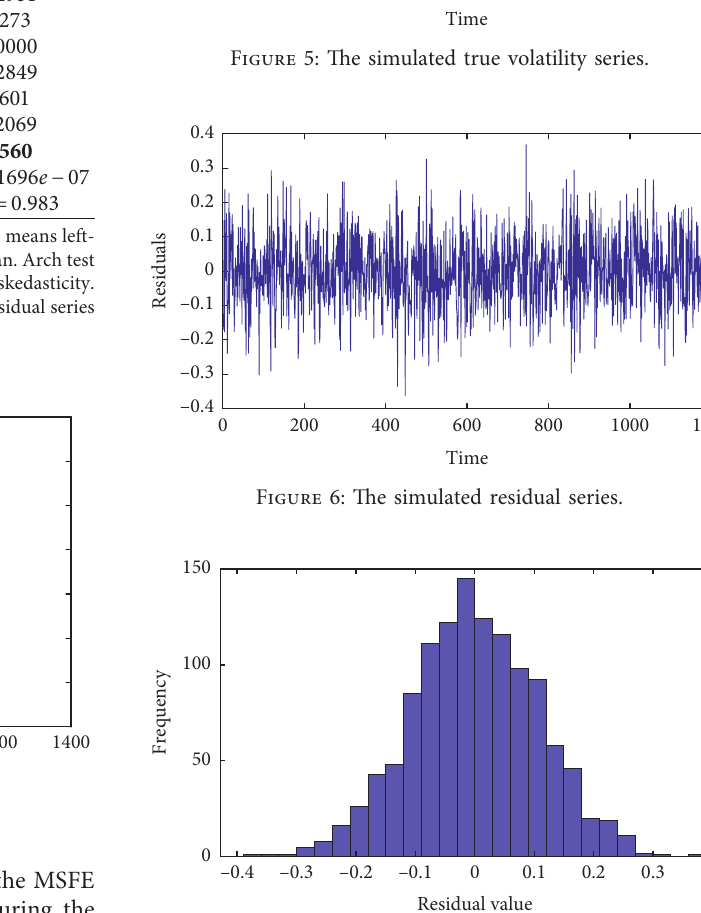
Figure 7: The histogram of simulated residual